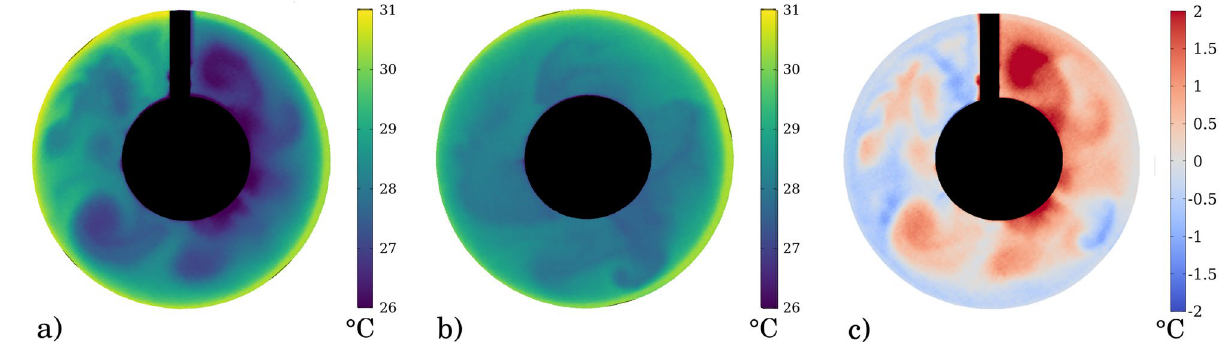
Figure 2. Water surface temperature patterns. Infrared thermographic maps of the water surface temperature (WST) fields in the “closed” ( a ) and “open” ( b ) leg of an experiment, and their differences (“open” minus “closed”, c ). ( (cid:31) = 2.0 rad/s, (cid:31) T r = 11 ◦ C, H = 5 cm). The figure was created using Gnuplot version 5.2, Release 5.2.8 (freely available and downloadable at http:// www. gnupl ot.